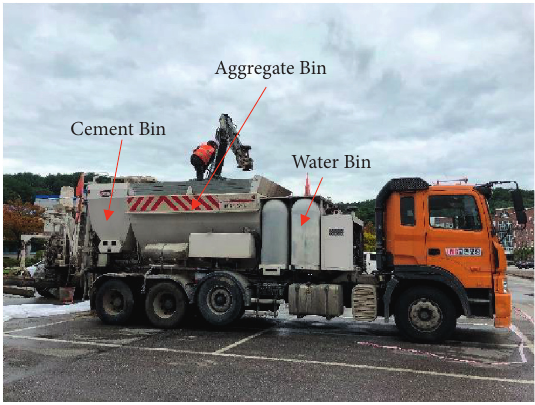
Figure 4: Mobile mixer for concrete overlay